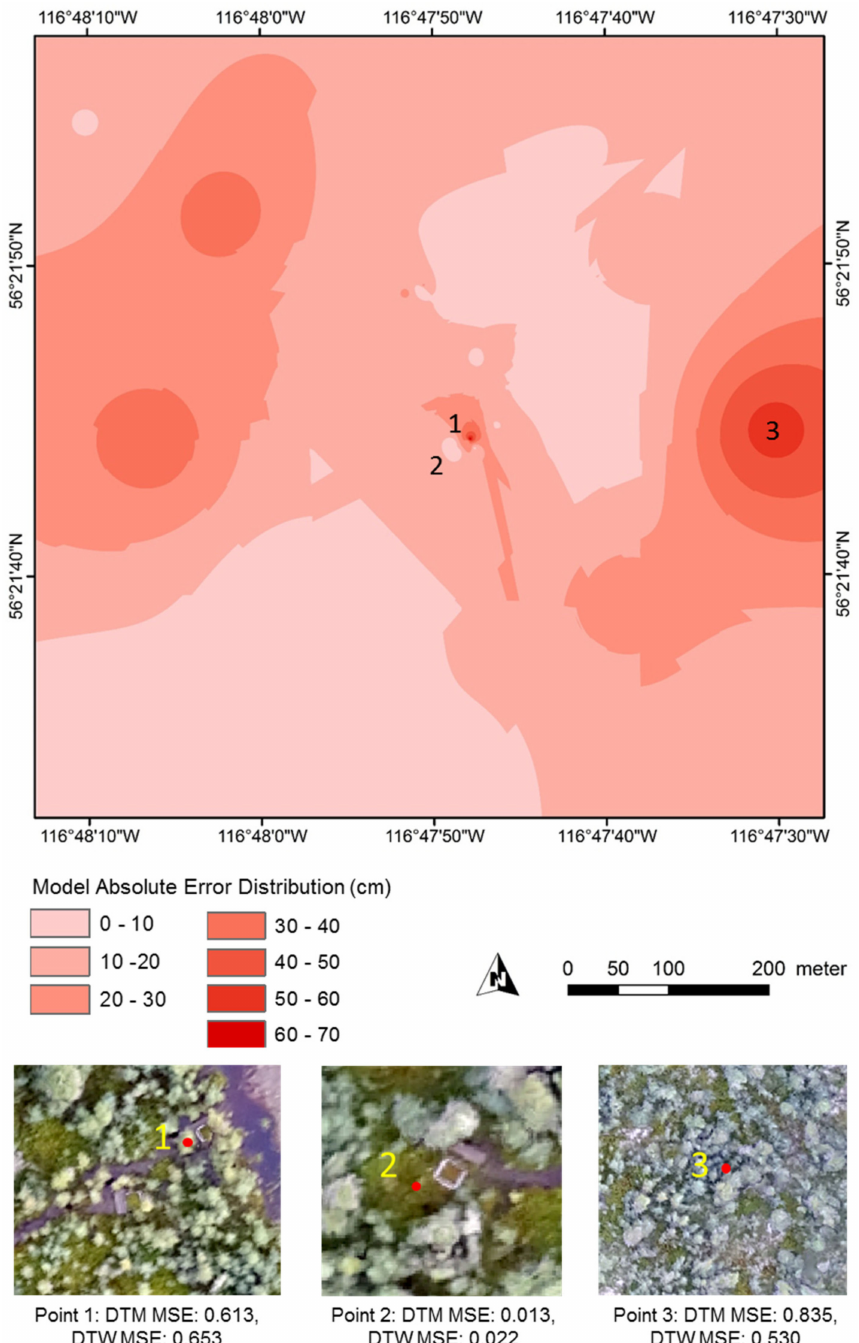
Figure 8. Visualization of the spatial distribution of (DTW) model errors, created by interpolating the absolute errors from 31 temporally coincident well measurements. Insets (bottom) show detailed visualizations of three well sites with relatively low (point 2) and high (points 1 and 3) observed